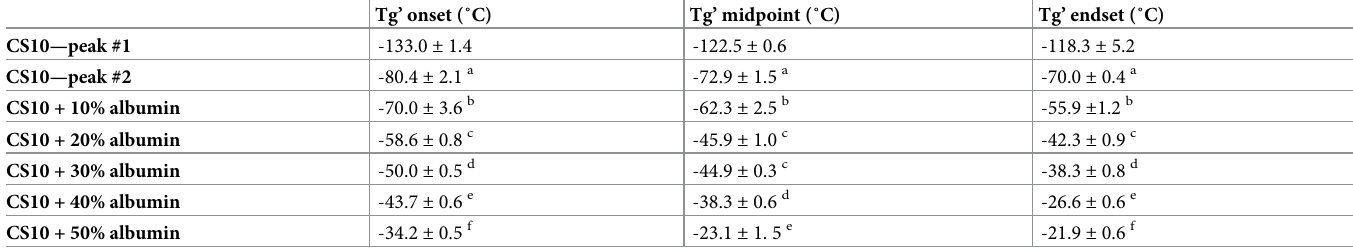
Table 1. Glass transitions characterized by onset, midpoint and endset temperatures in mixtures of albumin suspended in CryoStor10 and measured by DSC upon warming (n = 3 ± SD).